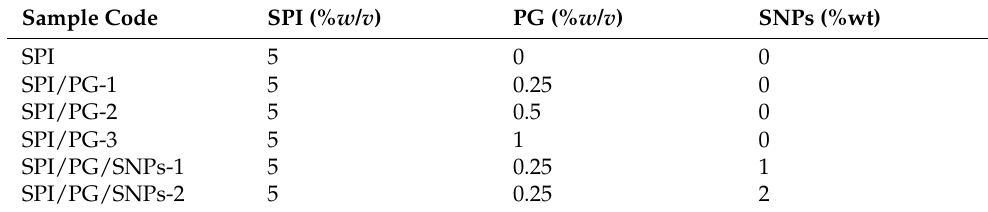
Table 1. Formulations of SPI/PG/SNPs active